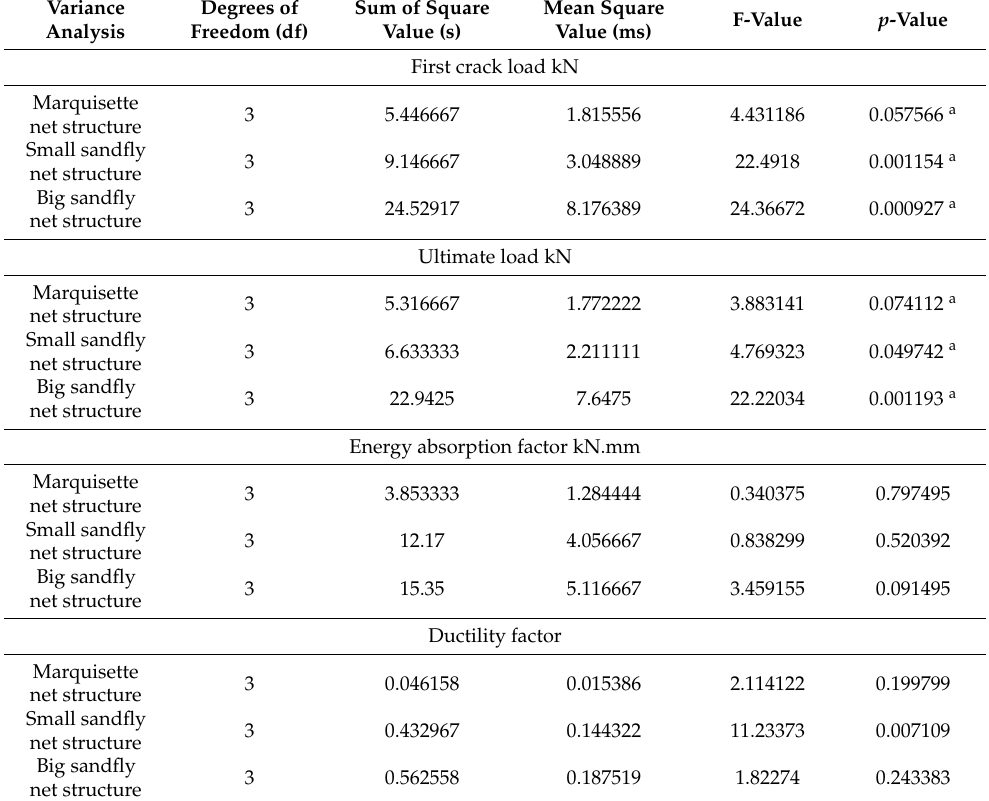
Table 6. Analysis of variance between chicken mesh ferrocement and warp knitted structure rein- forced